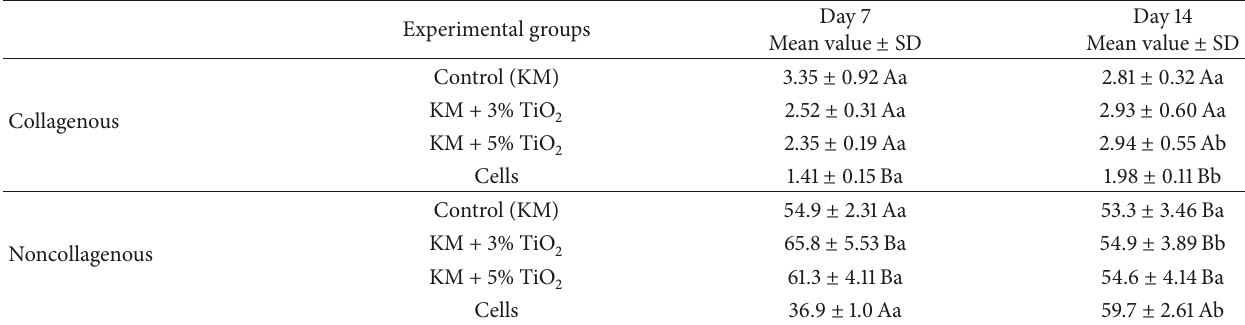
Different uppercase letters indicate intergroup differences by the Kruskal-Wallis test ( 𝑝 ≤ 0.05 ), whereas different lowercase letters indicate intragroup difference by the Friedman test ( 𝑝 ≤ 0.05